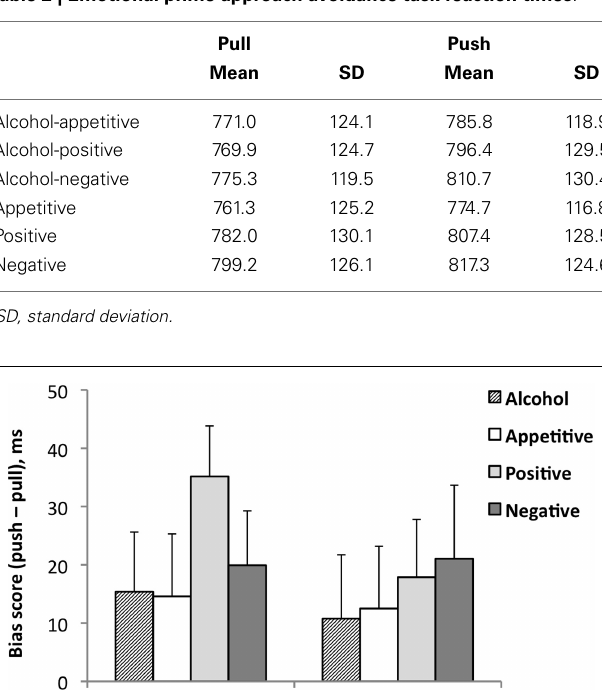
Table 2 | Emotional prime approach avoidance task reaction times .